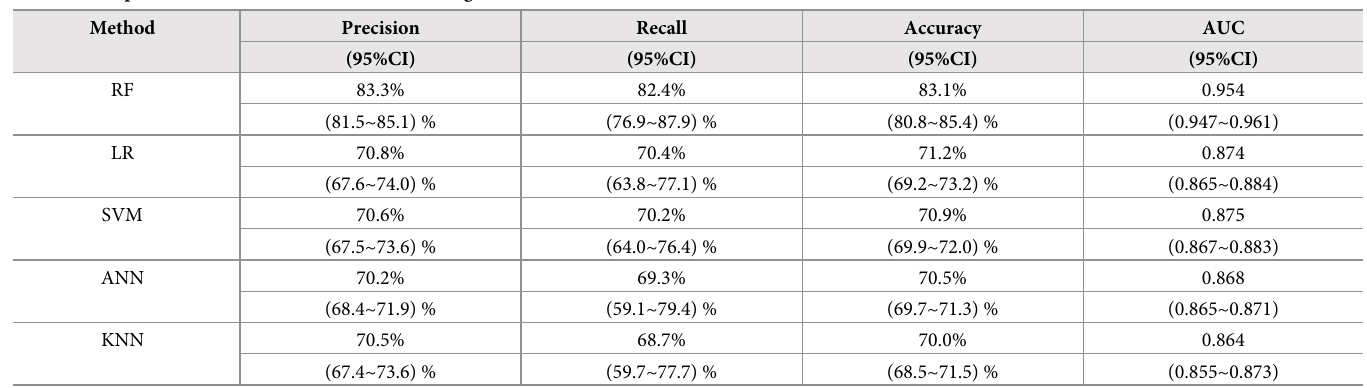
Table 2. The performances of the five machine learning methods.